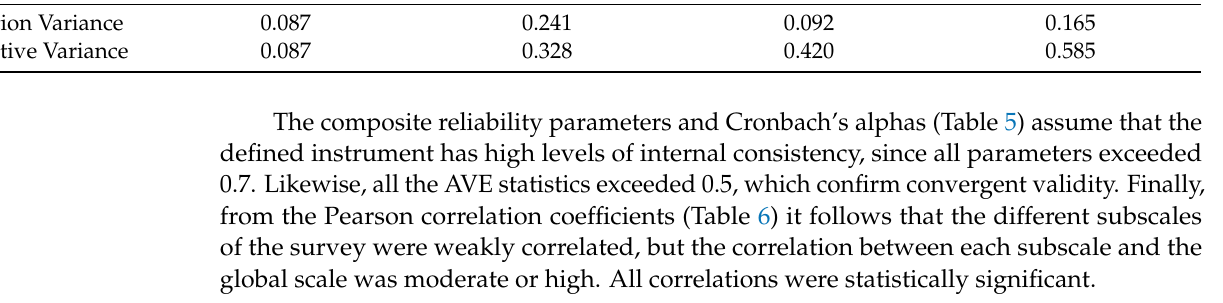
Table 5. Cronbach’s alpha, CR and AVE parameters.